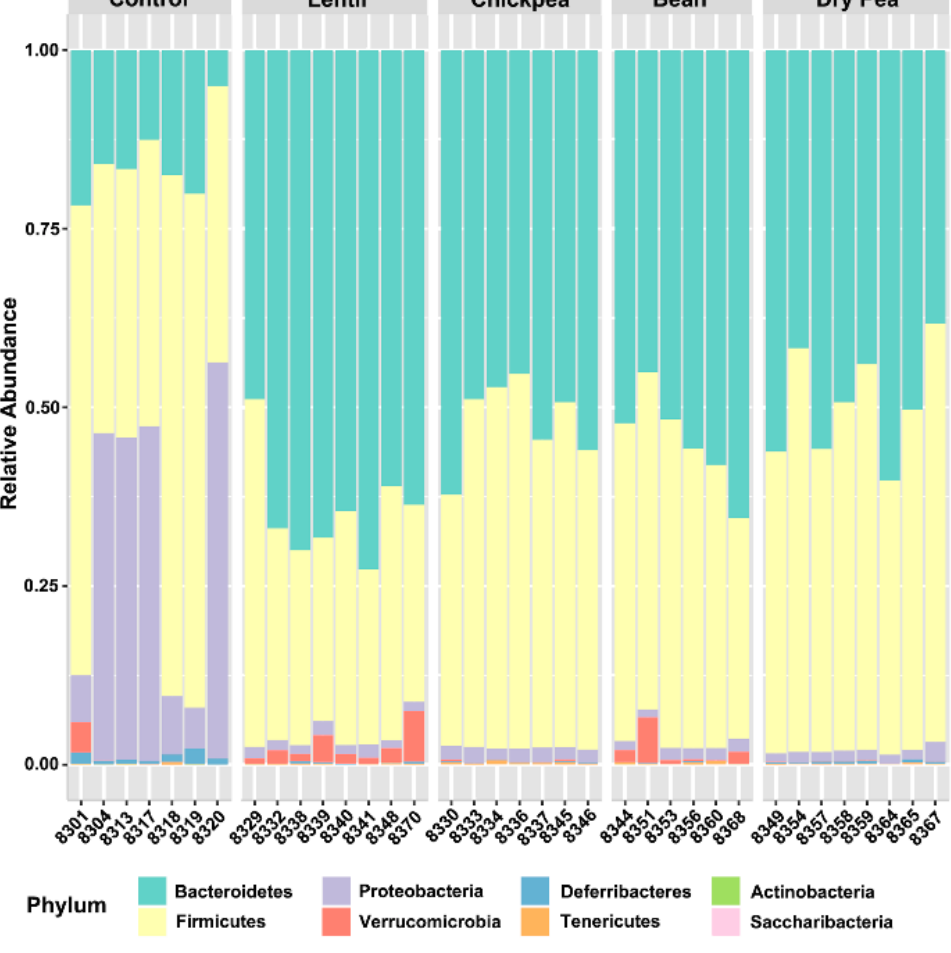
Figure 1. Relative abundance of identified Phyla across individual samples per each diet formula-